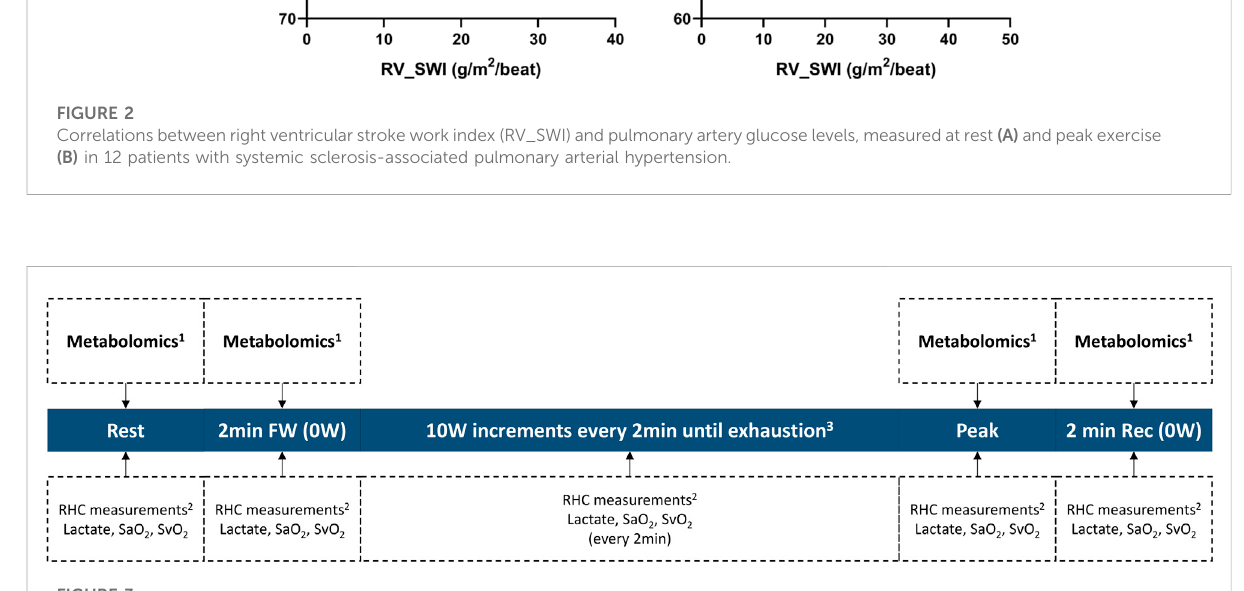
FIGURE 3 Invasive exercise protocol. 1 Collected from the pulmonary artery catheter and from the radial artery catheter. 2 RHC measurements include heart rate, blood pressure, right atrial pressure, pulmonary arterial pressure, pulmonary arterial wedge pressure, and cardiac output. 3 Study length varies on an individual basis, until exhaustion. RHC right heart catheterization; SaO2 radial artery O2 saturation; SvO2 mixed-venous O2 saturation; workload in Watts